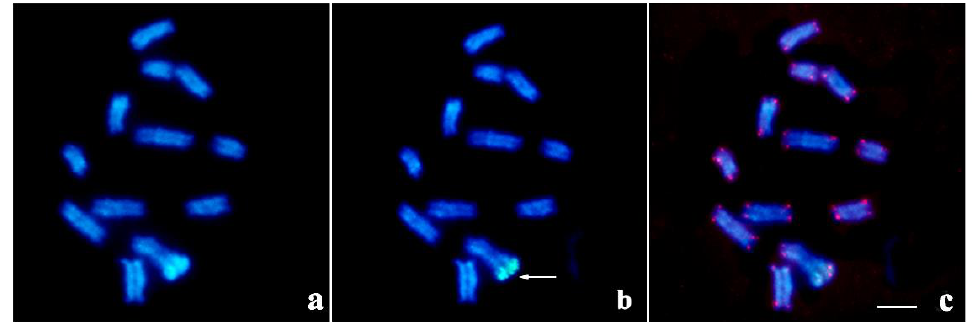
Figure 6. Meiotic chromosomes in cytotype A (2n = 24) of T. silvestris (blue: DAPI; green: 45S rDNA; red: telomeres): ( a ) C-banding; ( b ) FISH with 45S rDNA probe (arrow); ( c ) FISH with telomeric probe. Bar: 10 µm.